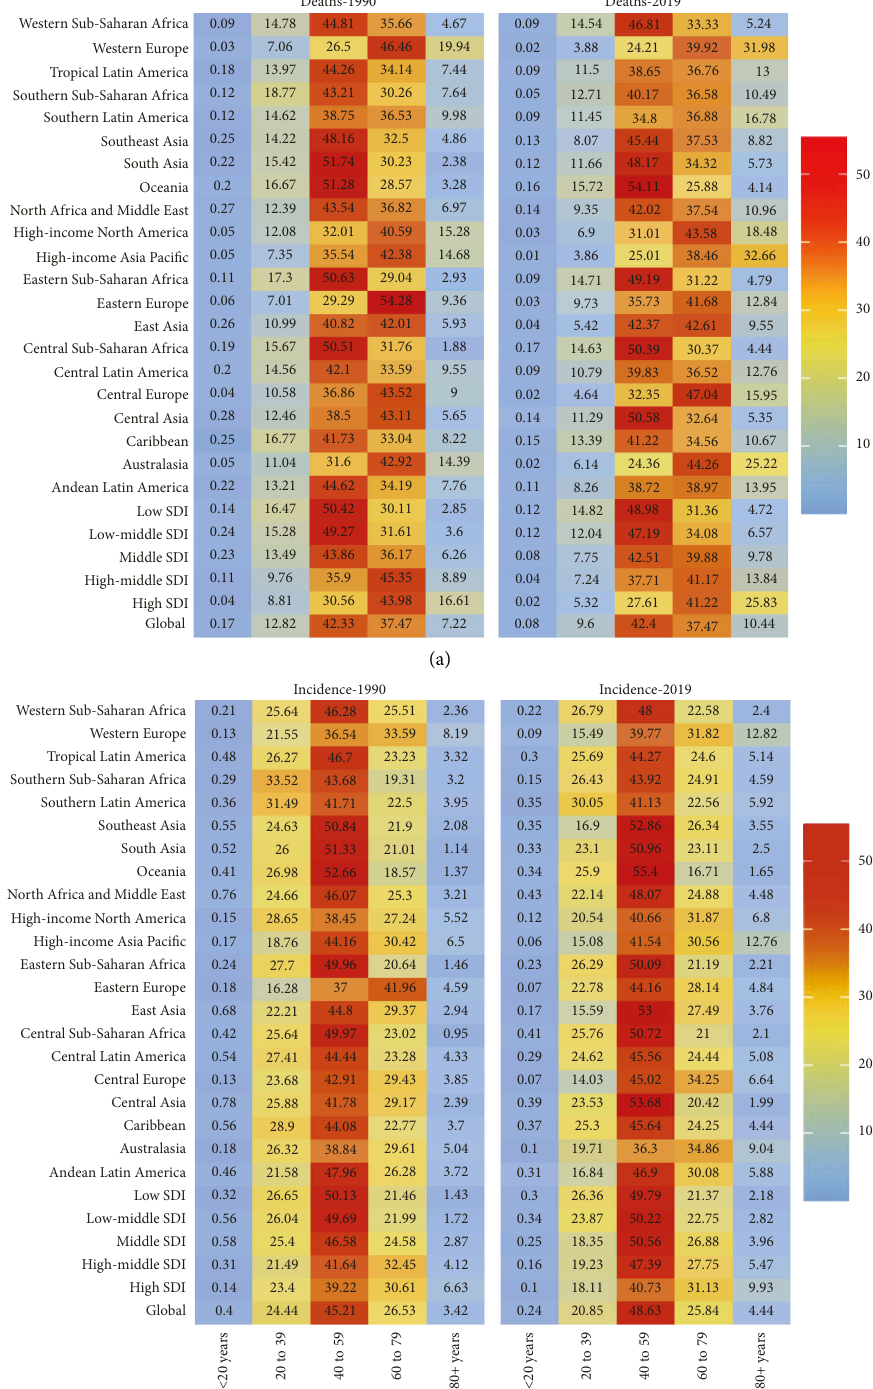
Figure 3: Incidence rate of cervical cancer and the distribution of death cases in different ages and regions. (a) The death rate from 1990 to 2019. (b) Incidence from 1990 to